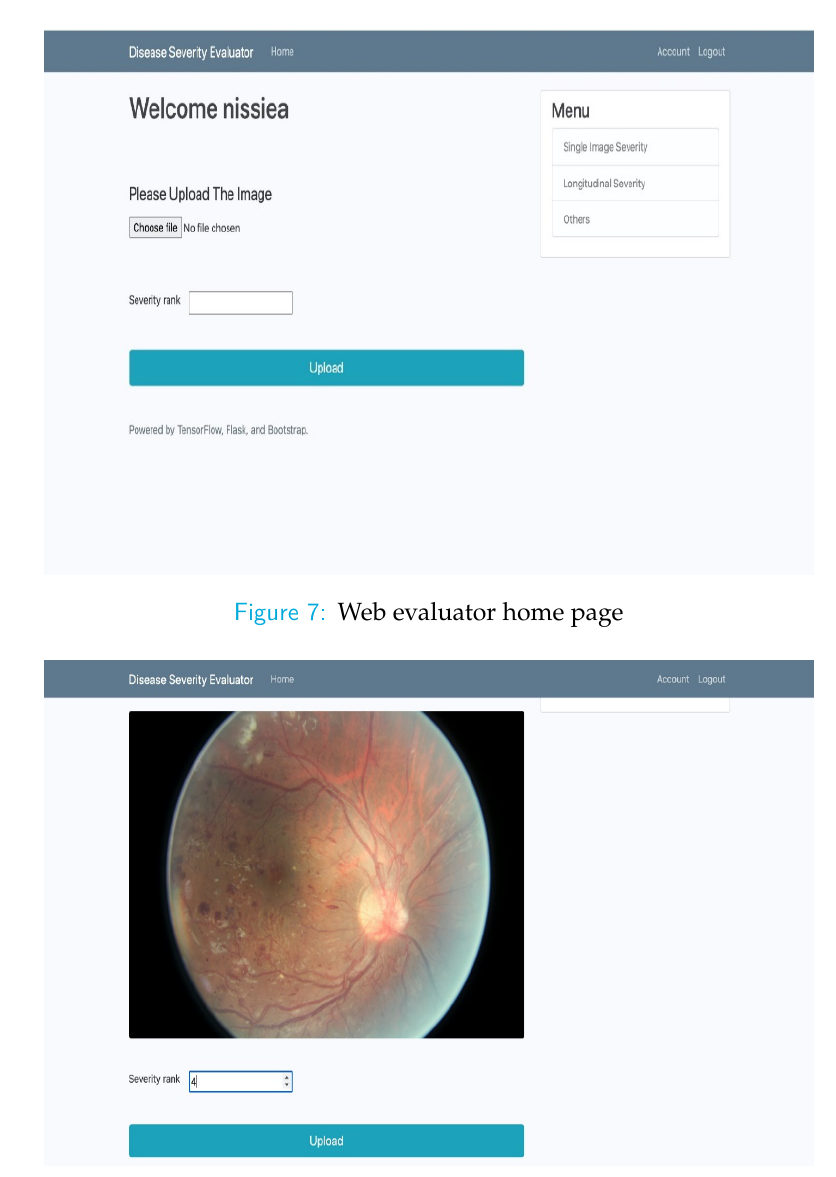
Figure 8: Web app fundus image